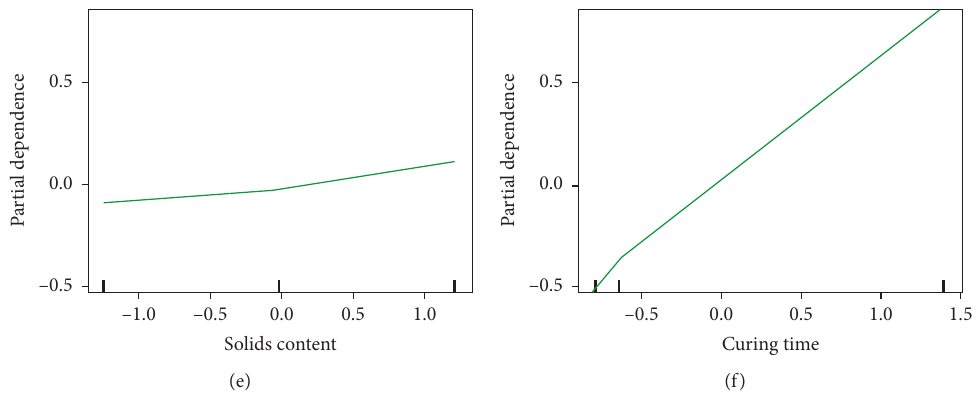
Figure 16: Partial dependence plots and IS values for each input variable. (a) IS � 0.085. (b) IS � 0.011. (c) IS � 0.257. (d) IS � 0.045. (e) IS � 0.198. (f) IS �